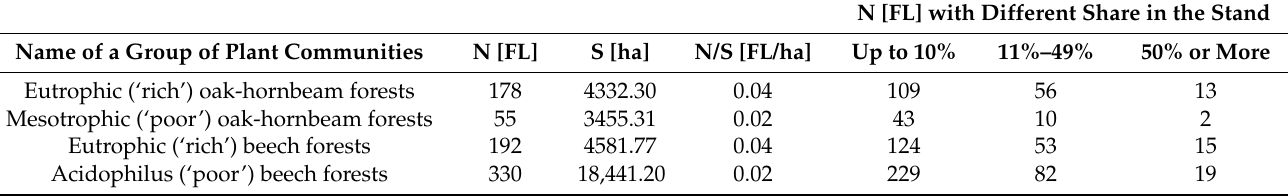
Table 3. The number (N) of fir localities (FL) (total and broken down into a different share in the stand) within the four most important groups (S > 3000 ha) of natural vegetation in the area covered by the study. Table 3 does not include the plant communities in Table 2 that generally have not many fir localities (FL) and the area of which is less than 3000 thousand ha. N [FL] with Different Share in the Stand Name of a Group of Plant Communities